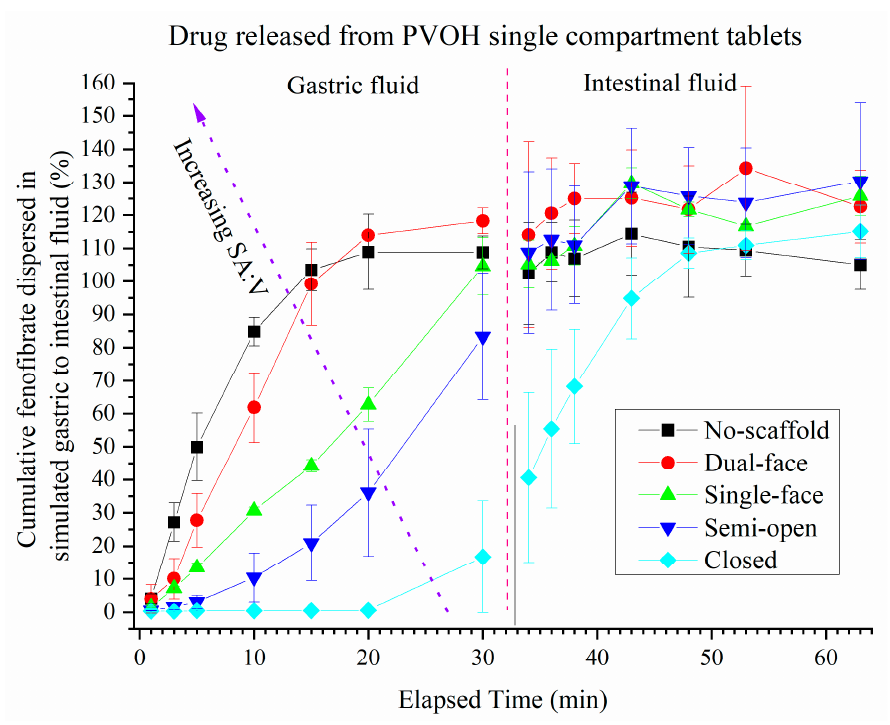
Figure 10. Drug release from different single-compartment PVOH-based scaffolds containing fenofibrate-loaded SMEDDS measured by HPLC. (Error = AVG ± STD, n = 4 for closed and single face series, n = 3 for semi-open and dual-face series, n = 6 for no-scaffold series). The dashed red line indicates the dispersant transition period.